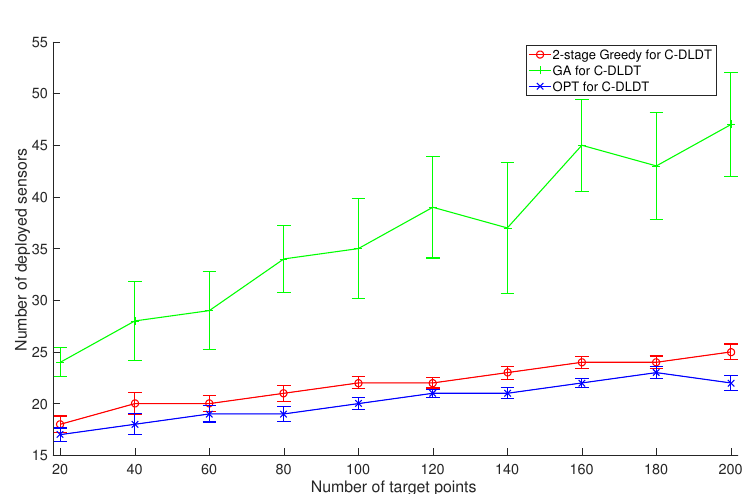
Figure 10. Comparison of the average performance with the standard deviation between the 2-stage Greedy Algorithm, Genetic Algorithm (GA), and the Optimal Algorithm (OPT) for C-DLDT in response to a varying number of target points.